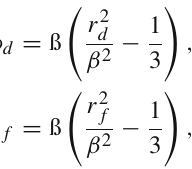
Fig. 4 The deflecting trajectories governed by equations of motion given in Eqs. (39) and (40). The plots demonstrate a OFK and b OSK. Aswecansee,thehyperbolicformofOFKallowsincomingtrajectories to enter the cosmological horizon before their escape to infinity. On